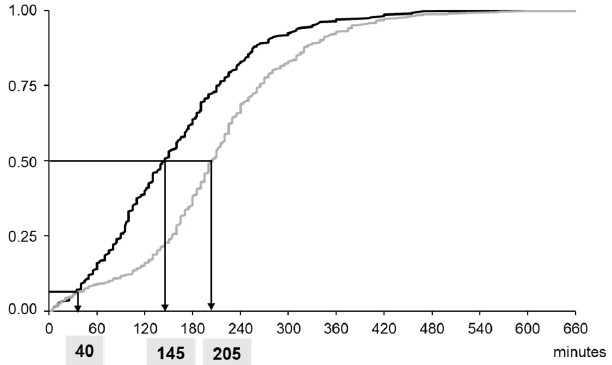
Diagnostics 2022 , 12 , x FOR PEER REVIEW Figure 3. Cumulative frequency distribution of patient length of stay before (grey line) and after (black line) the implementation of AQT90 in the emergency department.